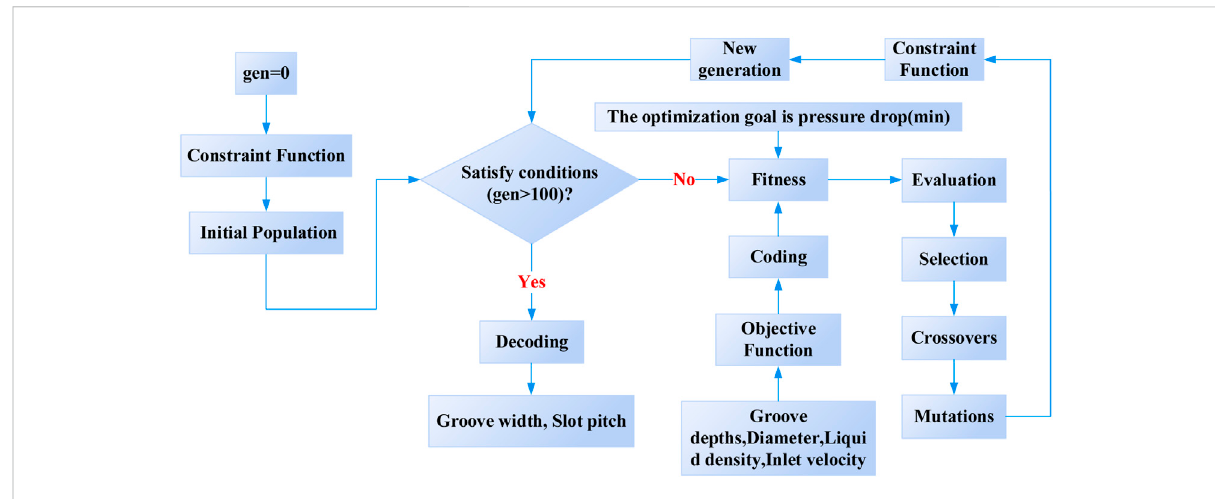
FIGURE 6 BBHE optimization